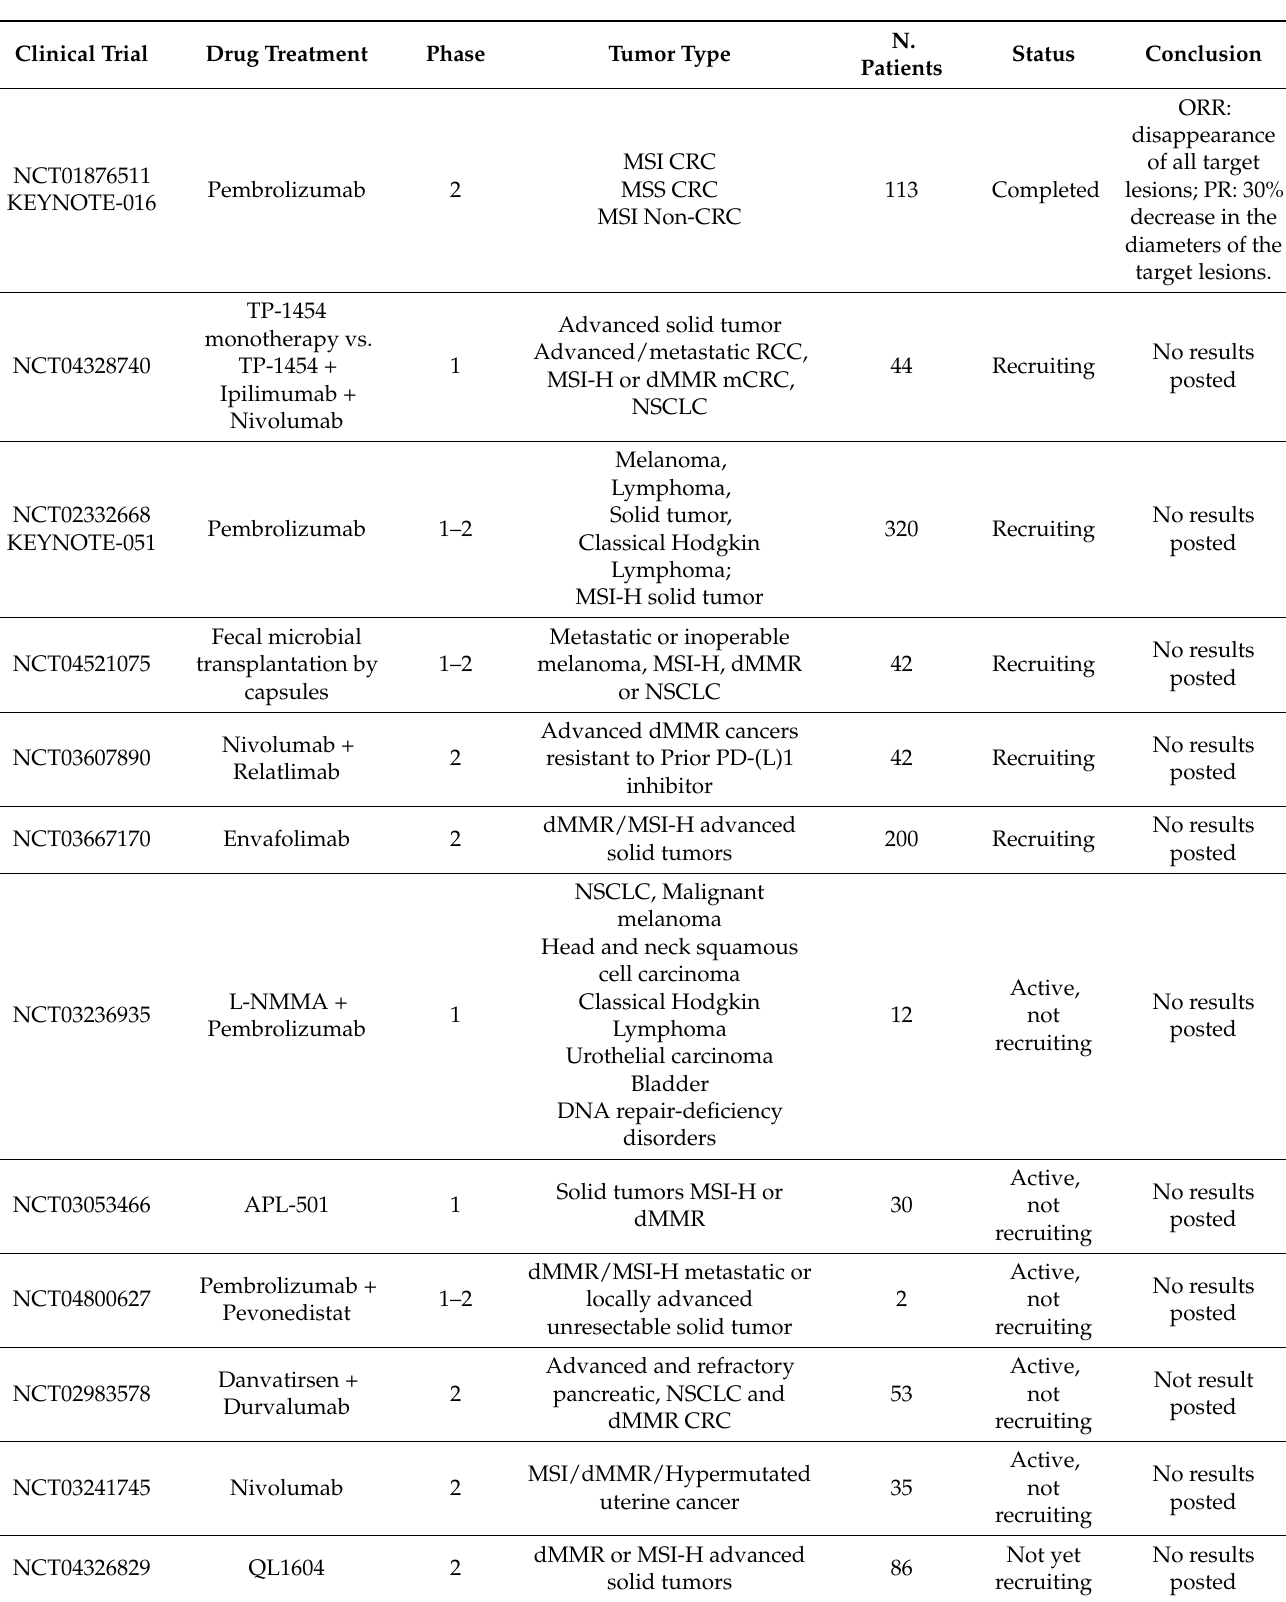
Table 9. Clinical trials for immune checkpoint inhibitors treatment of other MSI/no-MSI-H